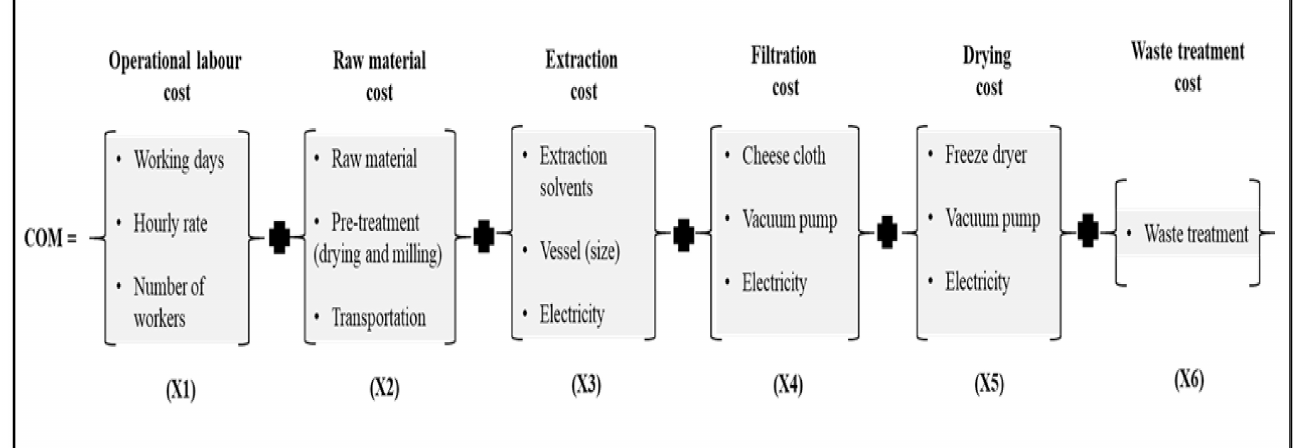
Figure 3. Schematic representation of various activities during the extraction